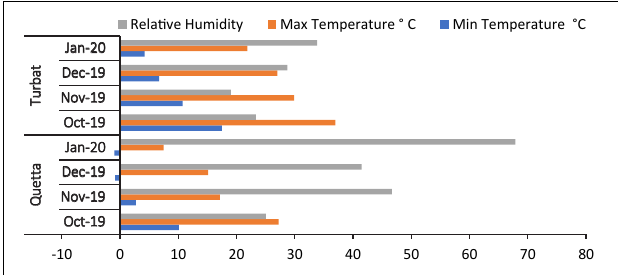
FIGURE 1 | Average monthly maximum, minimum temperature, and relative humidity during the experiment period October 2019–January 2020.